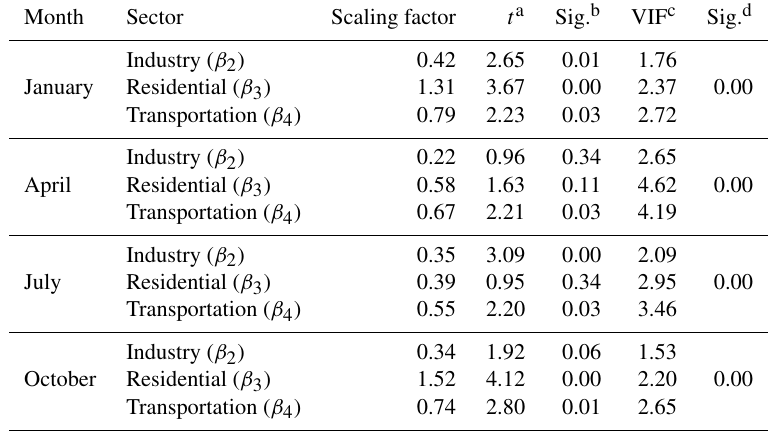
Table 1. The scaling factors and statistical indicators from the multiple regression model for estimation of JS-posterior. Month Sector Scaling factor t a Sig. b VIF c Sig. d Industry ( β 2 January